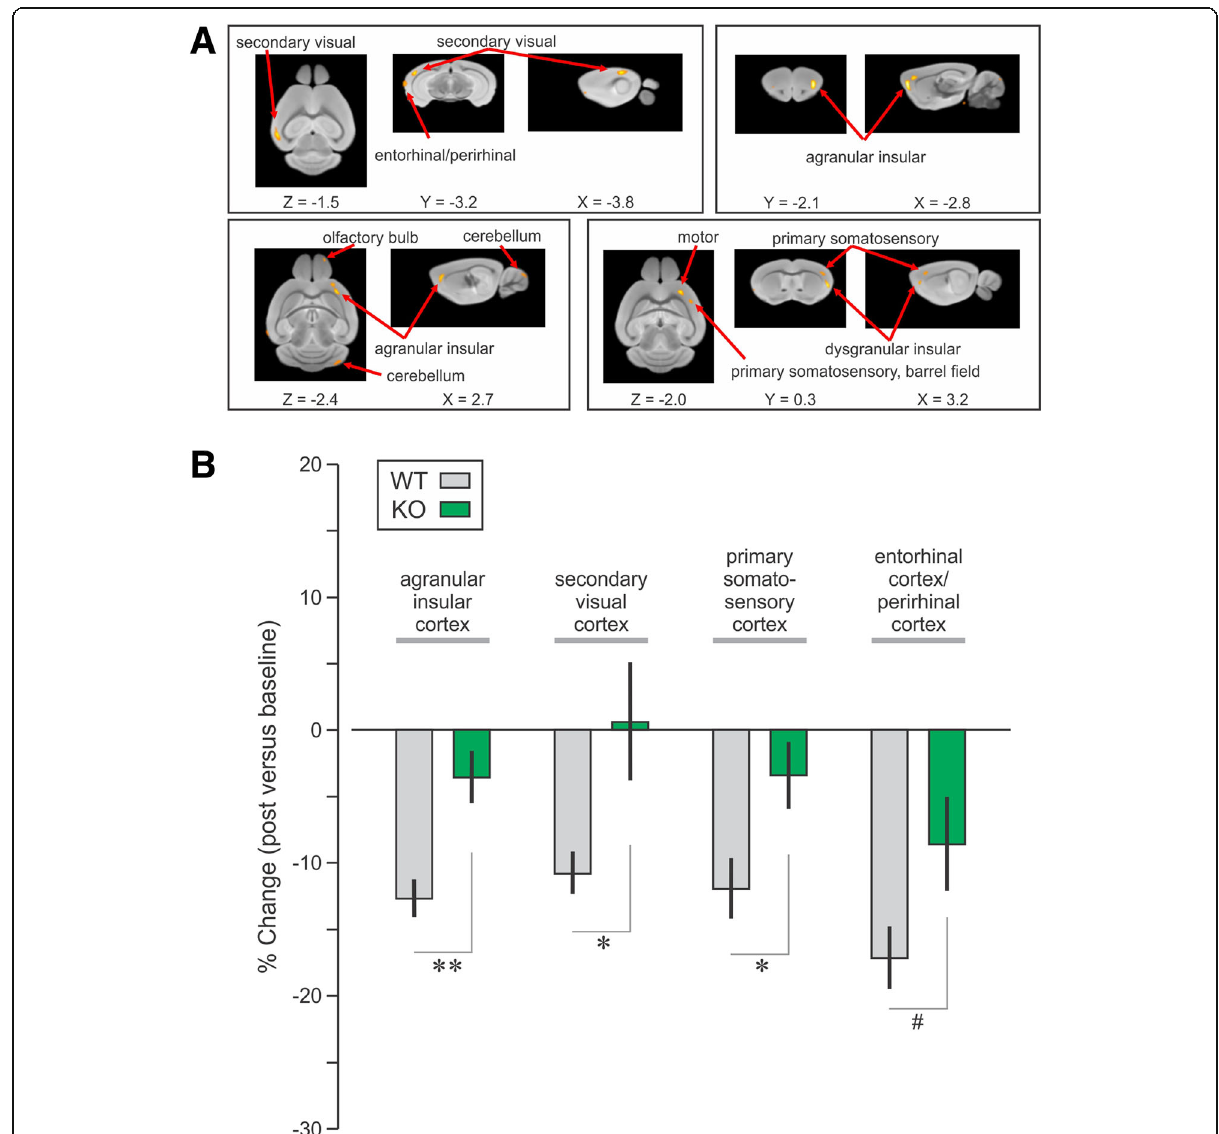
Fig. 1 Regional metabolic activity was decreased in the WT mice after binge alcohol and deficiency in CIRP attenuated these decreases in metabolic activities. a 18 FDG-PET images from WT mice were analyzed by SPM8 software. Regions with decreased metabolic activity were aligned onto a standard mouse MRI brain template and regions anatomically identified based on a three-dimensional mouse brain atlas (Paxinos and Franklin 2008). Using bregma as the reference point, the Y-coordinate corresponds to the anterior-posterior (AP) distance from bregma in the coronal plane, the X-coordinate corresponds to the sagittal or mediolateral (ML) plane, and the Z-coordinate corresponds to the axial or dorsoventral (DV) views of the brain regions. b Percent changes in globally normalized metabolic values in WT and CIRP − / − (KO) mice of specific regions identified in the WT group. Data are expressed as mean ± SE; * P < 0.05, * P < 0.001; # P = 0.069, KO vs. WT mice of respective